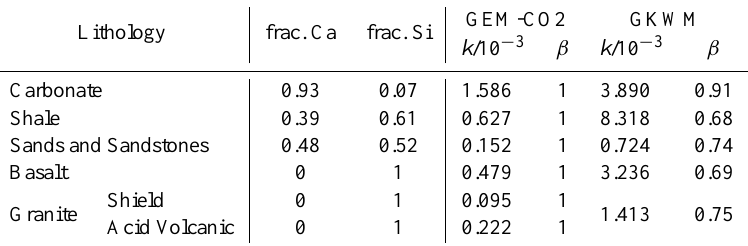
Fig. 12. Evolution of atmospheric CO 2 over 1 Myr for 1000 GtC (bottom) and 5000 GtC (top) emissions pulses, vs. a control run with no emissions (grey lines), with different values of runoff-temperature correlation constant. Table 2. Constants for 2-D weathering functions following the formula in Eq. (15) with F in units of Mol and R in units of myr − 1 . Note: shield and acid lithologies are combined into Granite in